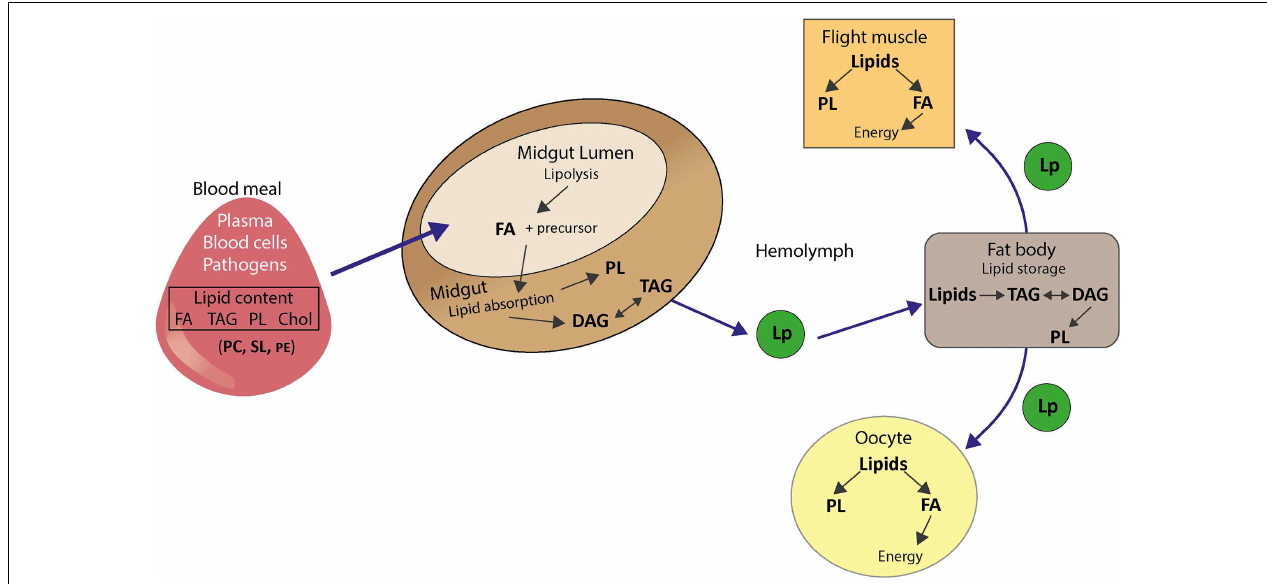
FIGURE 8 | Lipid metabolism in mosquitoes. FA, fatty acid; TAG, triacylglycerol; DAG, diacylglycerol; PL, phospholipid; Cho, cholesterol; PC, phosphatidylcholine; PE, phosphatidylethanolamine; SL, sphingolipid; Lp,